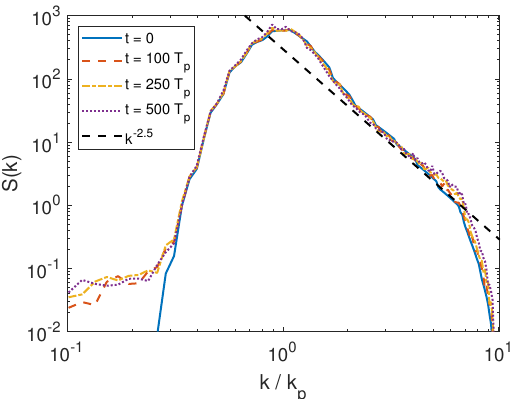
Figure 4. Time evolution of the omnidirectional spectrum for the case #16. A k − 2.5 power law is also